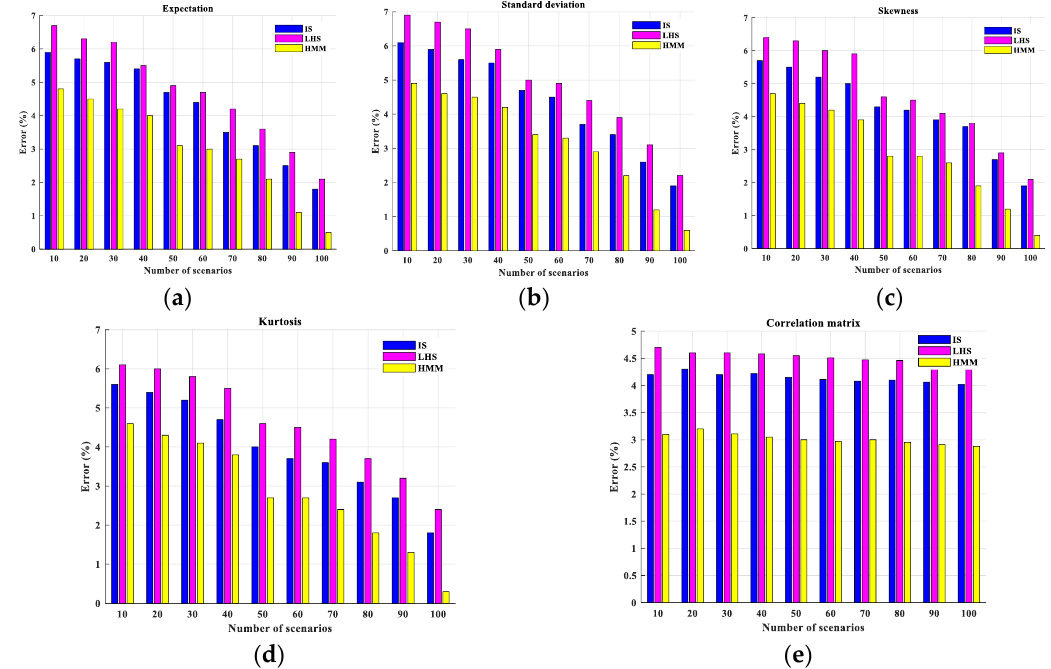
Figure 9. ( a ) Performance evaluation of the heuristic moment matching (HMM) method considering expectation, ( b )standard deviation, ( c ) skewness, ( d ) kurtosis, and ( e ) correlation matrix